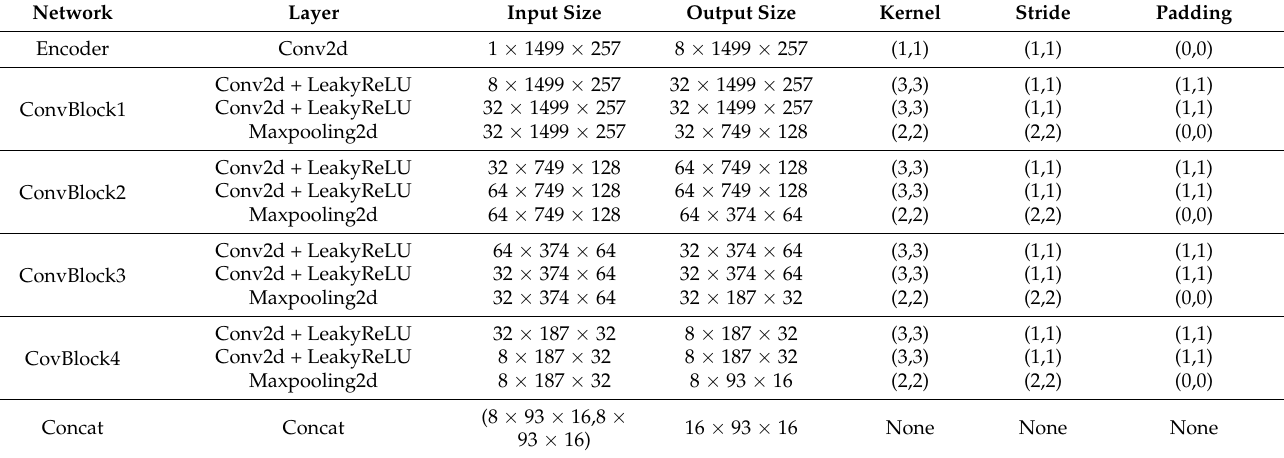
Table 3. The detailed settings of the model. The left input and the right input will share the same network structure within Encoder, ConvBlock1, ConvBlock2, ConvBlock3, and ConvBlock4, but the weights are not